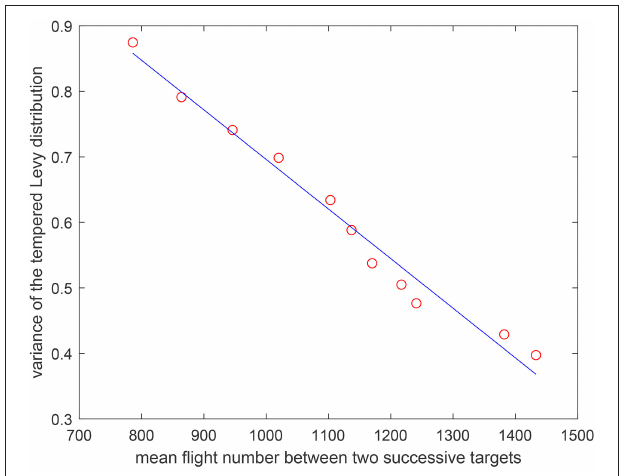
FIGURE 7 | Experimental results of searching efficiency for different λ and µ .